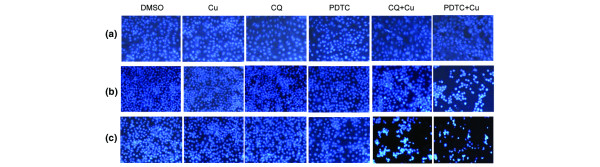
Induction of apoptosis by clioquinol (CQ) + copper and pyrrolidine dithiocarbamate (PDTC) + copper complexes in premalignant- and malignant-MCF10 cells. CQ and PDTC were mixed in a 1:1 molar ratio with CuCl2. Normal-, premalignant, and malignant-MCF10 cells were treated with CQ alone (CQ), copper alone (Cu), or CQ + copper (CQ+Cu) at 20 μM, or PDTC alone or PDTC + copper (PDTC+Cu) at 5 μM for 24 h. Dimethylsulfoxide (DMSO) was used as a control. After treatment, cells were stained with Hoescht for determination of apoptotic nuclei. Nuclei that were punctate or granular and bright were considered apoptotic. (a) The normal MCF10 cell line showed no apoptosis induction from the ligand, copper, or mixture (<2% in all cases). However, both (b) the premalignant MCF10AT1K.cl2 and (c) the malignant MCF10DCIS.com cells showed a dramatic induction of apoptotic nuclei after treatment with the mixture. (b) The percentages of apoptosic nuclei in MCF10AT1K.cl2 cells were: CQ+Cu, 10%; PDTC+Cu, 63%; and others <2%. (c) The percentages of apoptotic nuclei in MCF10DCIS.com cells were: CQ+Cu, 65%; PDTC+Cu, 75%; and others <2%.